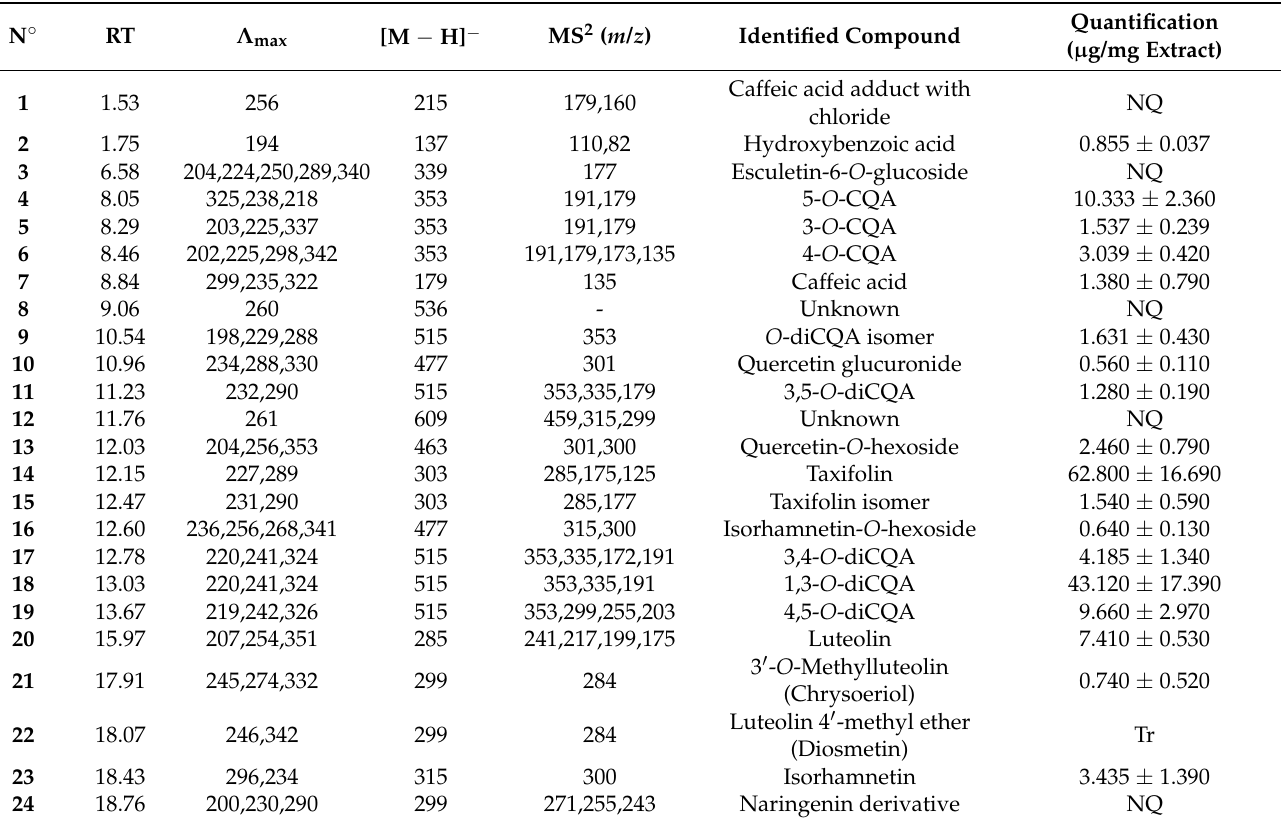
Table 1. Chemical composition of W. saharae extract by UHPLC-DAD-ESI/MS (retention time (RT), not quantified (NQ), traces (Tr), caffeoylquinic acid